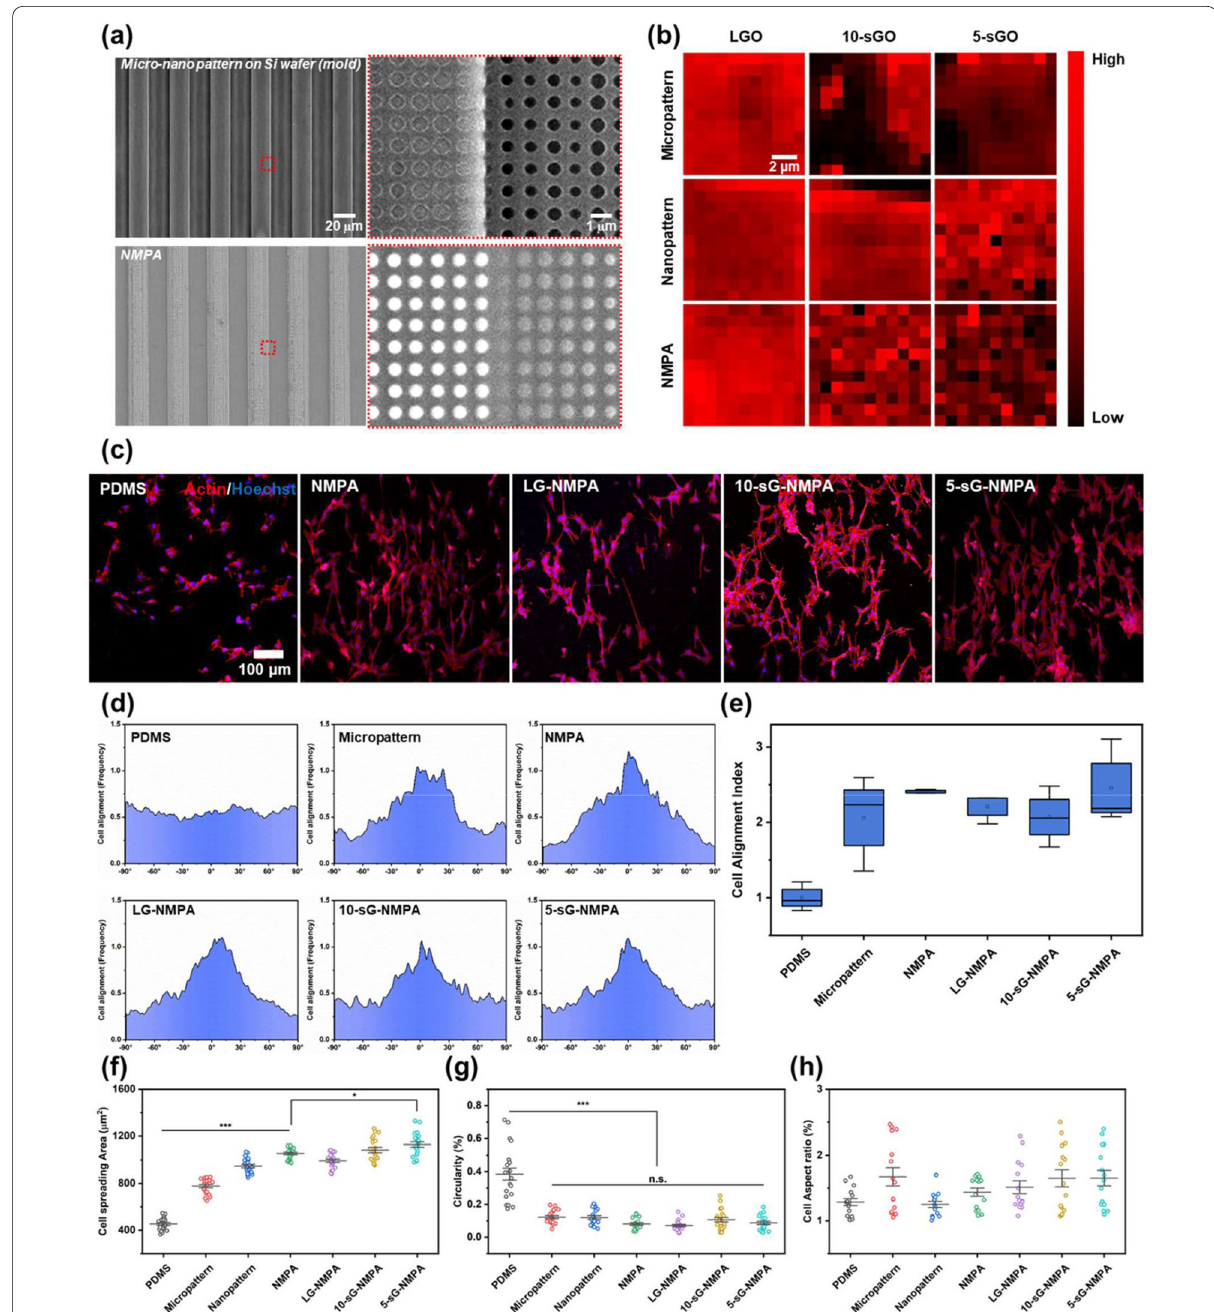
Fig. 4 Investigation of the cell behaviors on the GO‑coated NMPA. a FE‑SEM images of micro‑nano pattern on silicon wafer and NMPA. b Raman intensity map of the LGO‑, 10‑sGO‑, and 5‑sGO‑coated micropattern, nanopattern, and NMPA. c Confocal microscope images of the cells on bare PDMS, NMPA, LG‑NMPA, 10‑sG‑NMPA, and 5‑sGO‑NMPA immunostained with actin (Red) and Hoechst (Blue). d The cell orientation graph of the cells on the bare PDMS, micropatterned PDMS, NMPA, LG‑NMPA, 10‑sG‑NMPA, and 5‑sGO‑NMPA. e Cell alignment index of the cells on bare PDMS, micropatterned PDMS, NMPA, LG‑NMPA, 10‑sG‑NMPA, and 5‑sGO‑NMPA. f h Cell spreading area ( f ), circularity ( g ), and cell aspect ratio ( h ) of the − cells on the bare PDMS, micropatterned PDMS, nanopatterned PDMS, NMPA, LG‑NMPA, 10‑sG‑NMPA, and 5‑sGO‑NMPA. (* p 0.5, *** p ≤ ≤